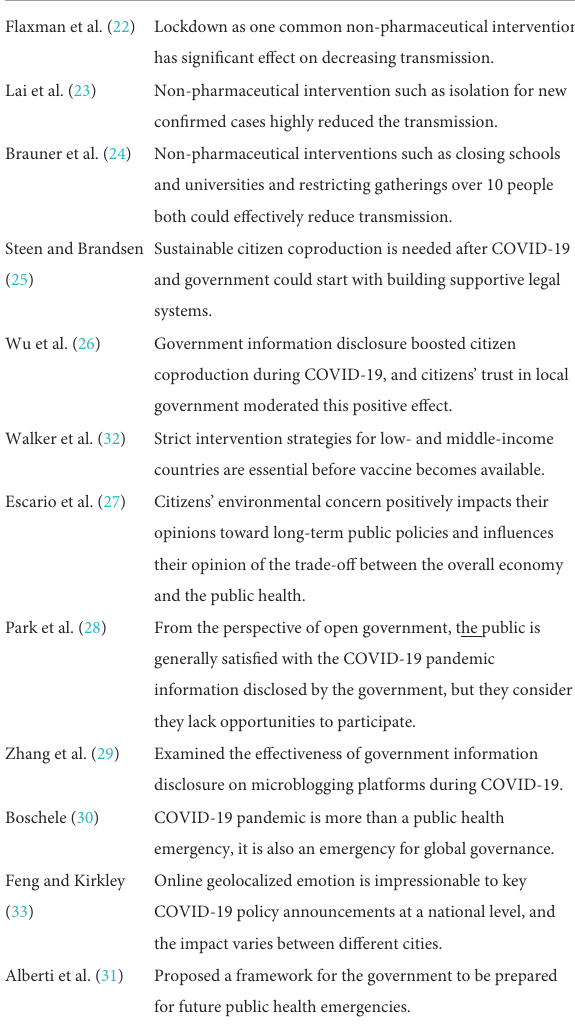
TABLE 1 Post COVID-19 pandemic literatures